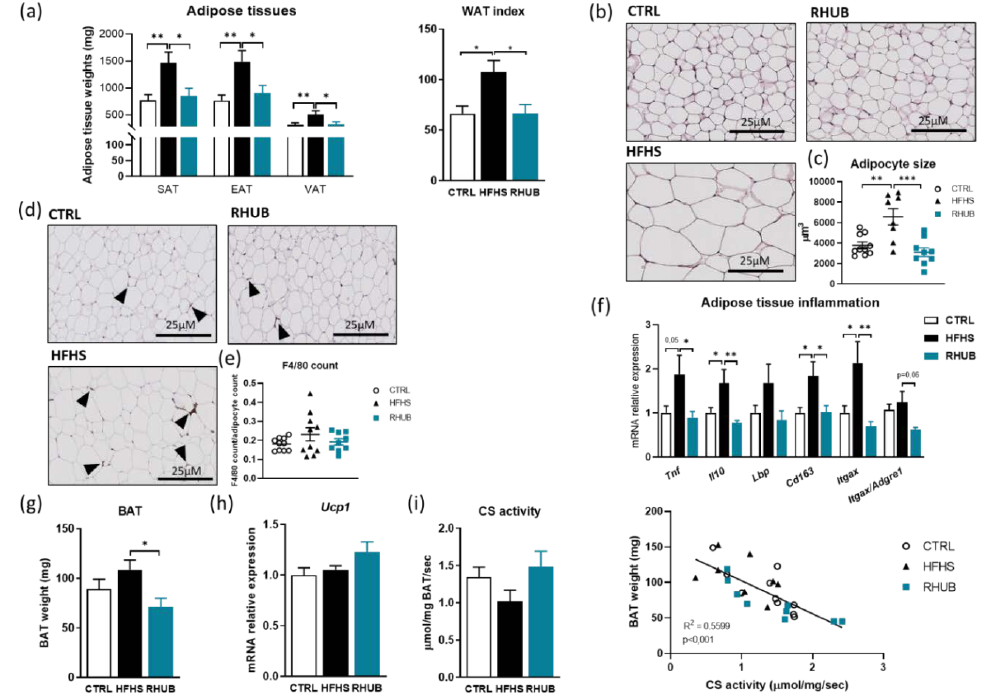
Figure 3. Rhubarb root extract protects against adiposity and adipose tissue inflammation ( a ) Adipose tissue weights (mg) measured after 8 weeks of experiment. SAT, subcutaneous adipose tissue, EAT, epididymal adipose tissue, VAT, visceral adipose tissue. White adipose tissue index measuring by adding all adipose tissue weights. ( b ) Representative adipose tissue Hematoxylin and Eosin staining. Scale bar, 25 µM. ( c ) Adipocyte size (µm 3 ). ( d ) Representative adipose tissue F4/80 immunohistological staining. Scale bar, 25 µM. ( e ) Counting of the F4/80 positive area. ( f ) mRNA expression of different inflammatory markers in the adipose tissue. ( g ) Brown adipose tissue weight (mg) measured after 8 weeks of experiment. ( h ) mRNA expression of Ucp1 in the brown adipose tissue. ( i ) Brown adipose tissue citrate synthase activity (µmol/mg BAT/sec) and correlation between brown adipose tissue weight and citrate synthase activity. p-value and R 2 come from linear regression. White, CTRL fed mice; Black, HFHS fed mice and Blue, HFHS fed mice supplemented with rhubarb. Data represent mean ± SEM. * p ≤ 0.05, ** p ≤ 0.01, *** p ≤ 0.005. WAT, White adipose tissue, BAT, Brown adi pose tissue, CS, citrate synthase. Figure 4. Rhubarb root extract affects antimicrobial peptides and intestinal renewal ( a ) mRNA expression of different antimicrobial peptides in the ileum (left panel) and in the colon (right panel).